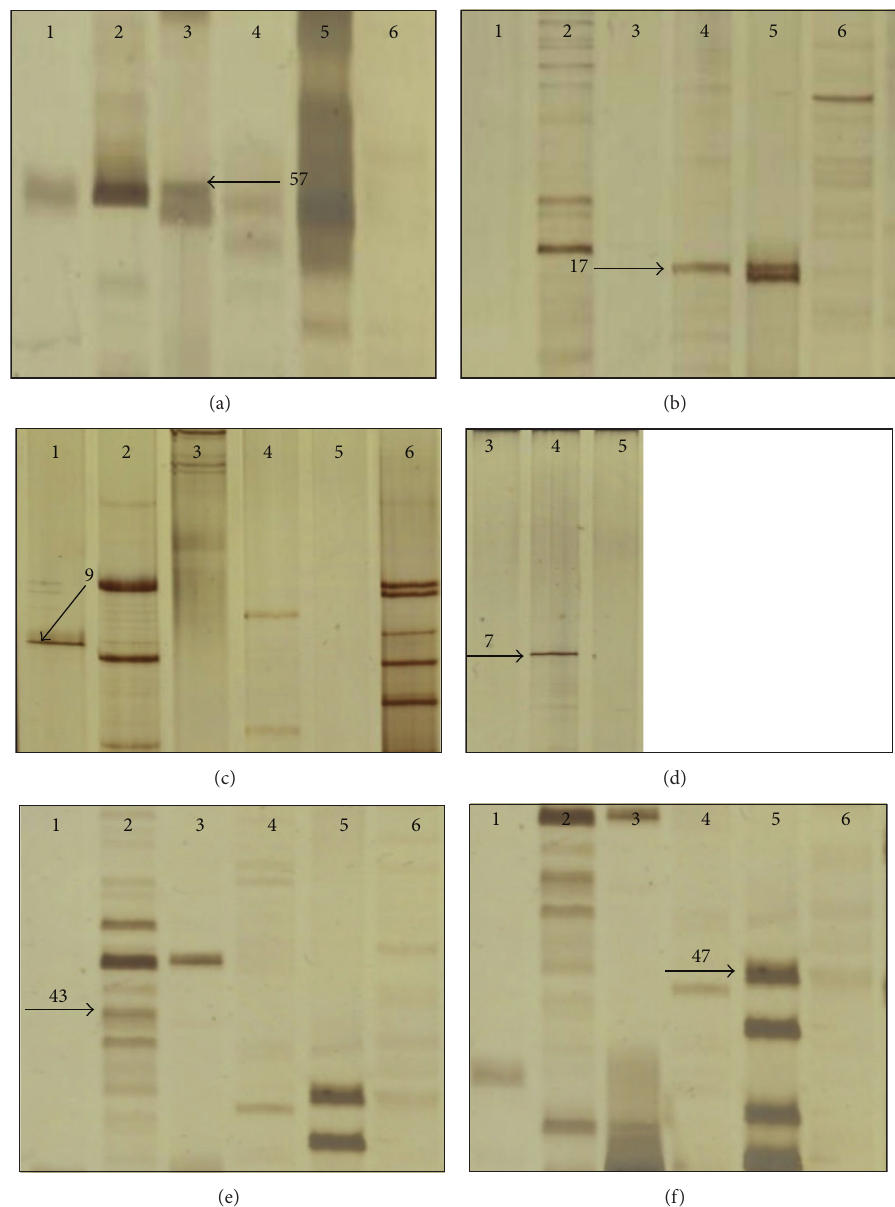
Figure 1: cDNA-AFLP patterns: zygotic versus somatic embryogenesis stages of M. acuminata ssp. malaccensis . Arrows with numbers showed TDFdifferentiallyexpressed.(a)Earlyembryogenesis,(b)lateembryogenesis,(c)immaturezygoticembryo,(IZE),(d)maturezygoticembryo (MZE), (e) immature somatic embryo (ISE), and (f) matured somatic embryo (MSE). The numbers are 1: IZE, 2: ISE, 3: ECS, 4: MZE, 5: MSE, and 6: germinated somatic embryo